Question: In a single sentence, describe what this figure presents.
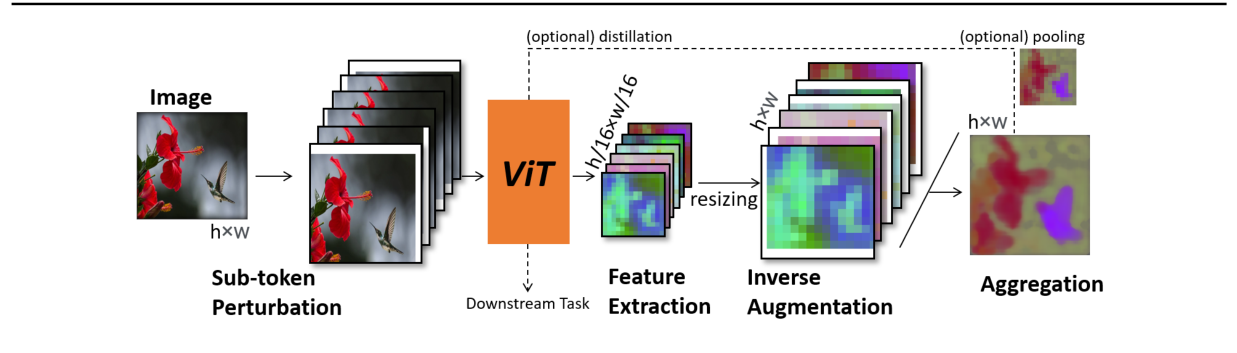
Answer: Schematic for SRT. SRT applies controlled perturbations to input images, extracting features through Vision Transformers (ViTs). These features are then upsampled to higher resolution and aligned using the inverse of the applied perturbations. Statistical aggregation, including mean and median, along the perturbation dimension, produces fine-grained feature representations. These features find utility in visualization and can also be seamlessly integrated back into the network for enhanced performance in downstream tasks.